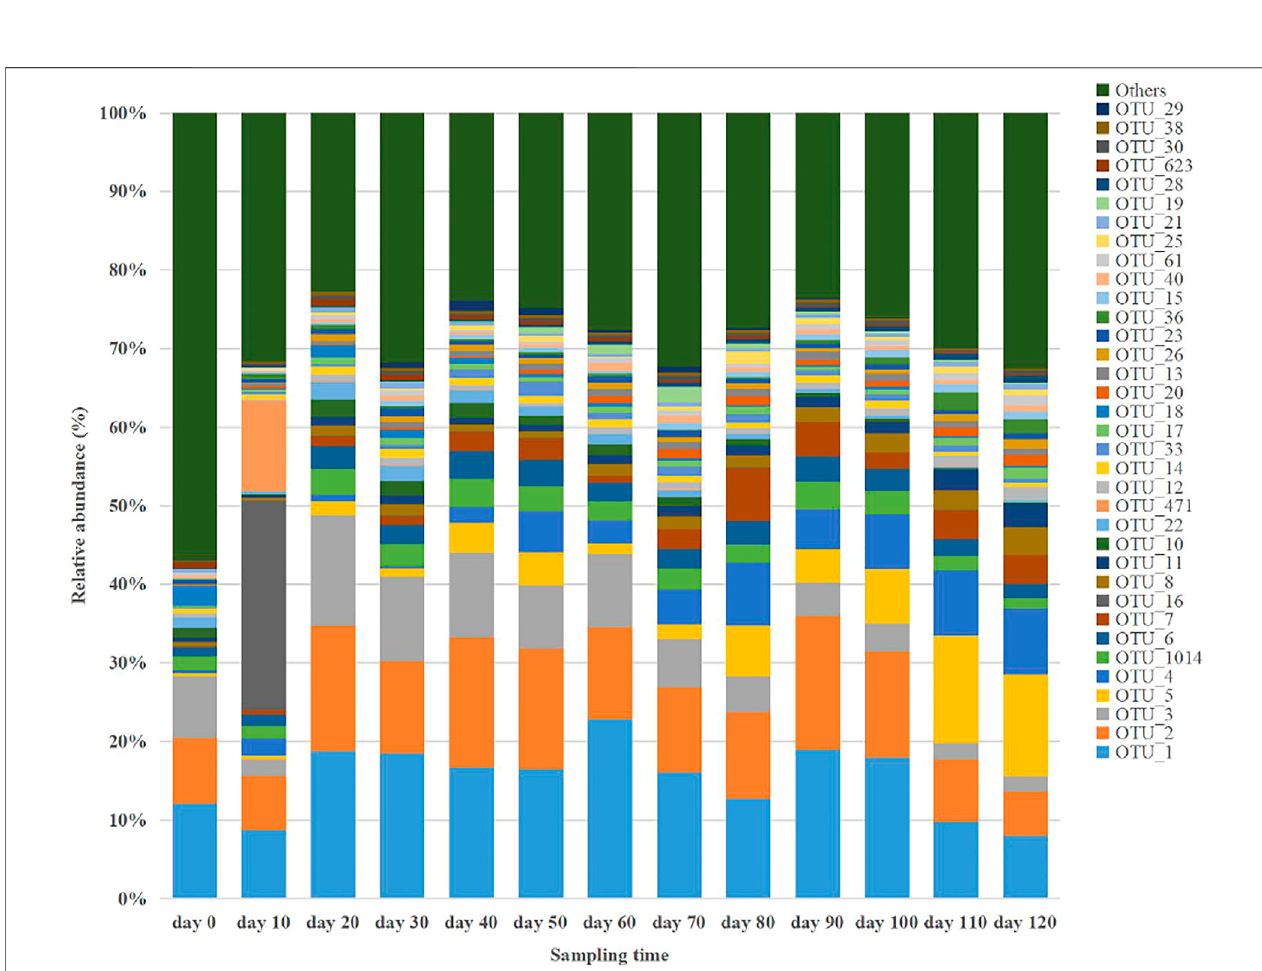
FIGURE 2 | Composition of the 35 most abundant bacterial OTUs at different anaerobic digestion time.